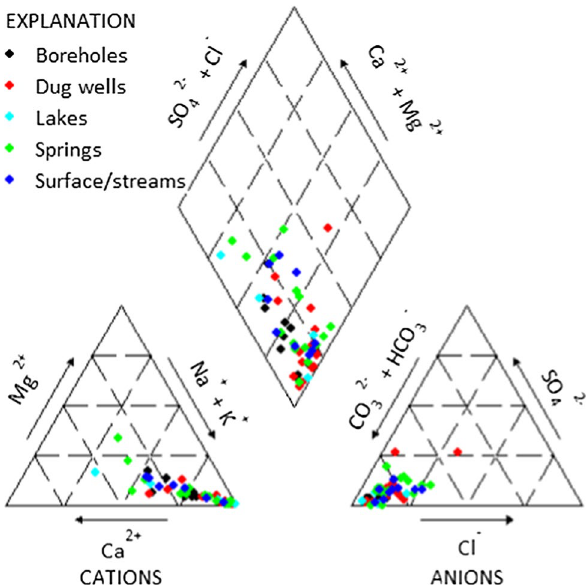
Fig. 16 Piper diagram for water samples from Meru district